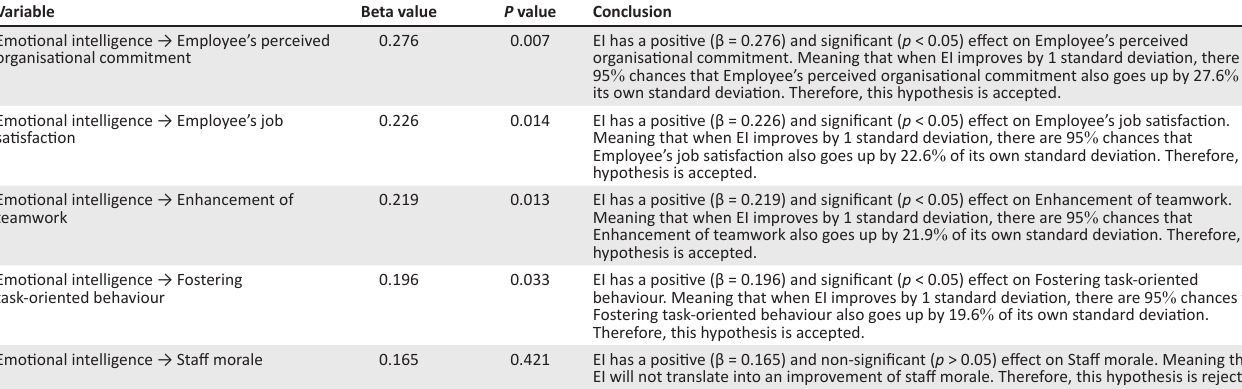
TABLE 4: Standardised regression weights and hypothesis conclusion.